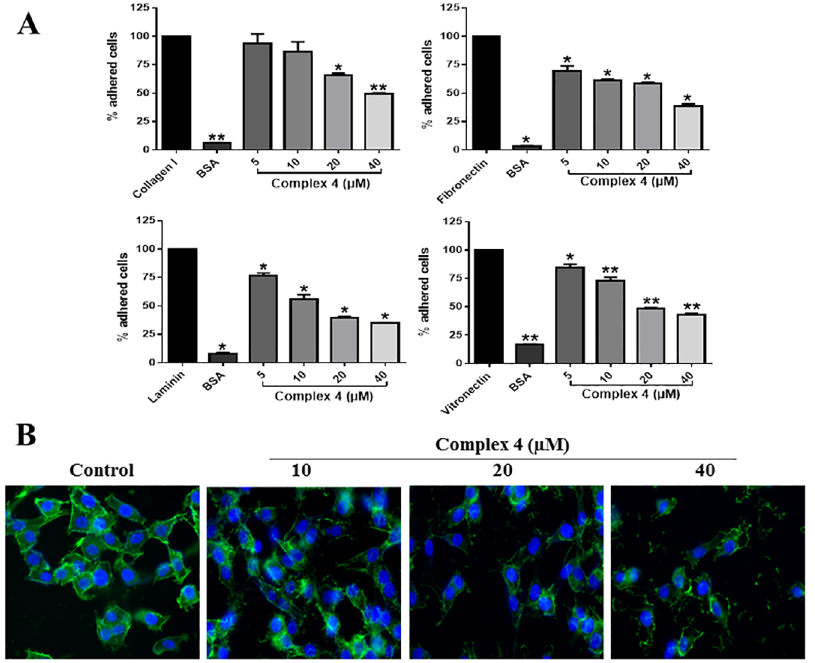
Fig 4. Effects of complex (4) on MDA-MB-231cell adhesion and cytoskeleton structure. (A) Type I collagen, fibronectin, lamininand vitronectinwere coated on the wells of a 96-wellplate. Complex (4) was incubatedwith MDA-MB-231 cells, which were subsequently platedon the ECM coatings. After washes, remaining cells were quantifiedby colorimetry. (B) MDA-MB-231 cells were incubatedwith complex (4) and then with Phalloidinand DAPI. Significantat the * p < 0.005, ** p < 0.001levels using ANOVA and Bonferroni tests.